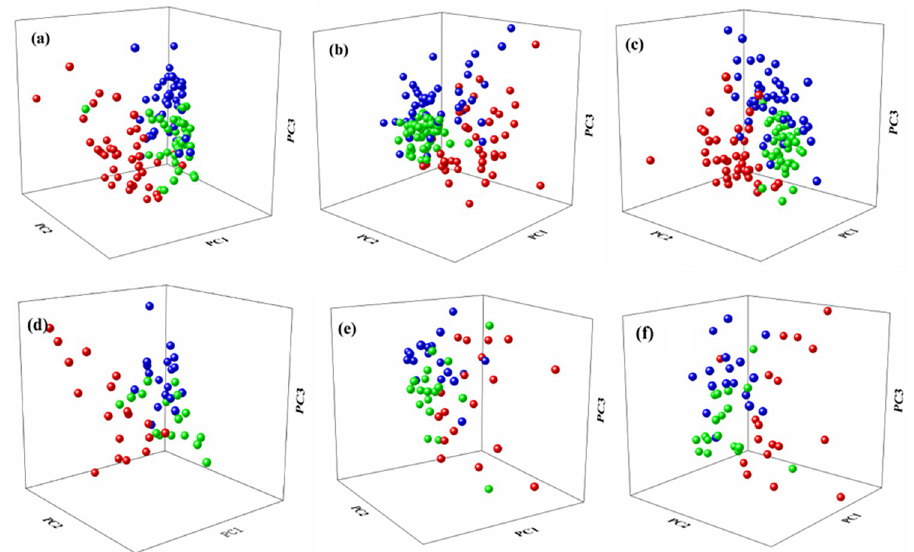
Fig 2. The first three PCs scatter plot in training set of a skin spectra, b flesh spectra, and c average spectra of them; the first three PCs scatter plot in test set of d skin spectra, e flesh spectra, and f average spectra of them. (The red balls represent samples of Hongxiangfei, the blue balls present samples of Manaiti and the green balls represent samples of Munage).